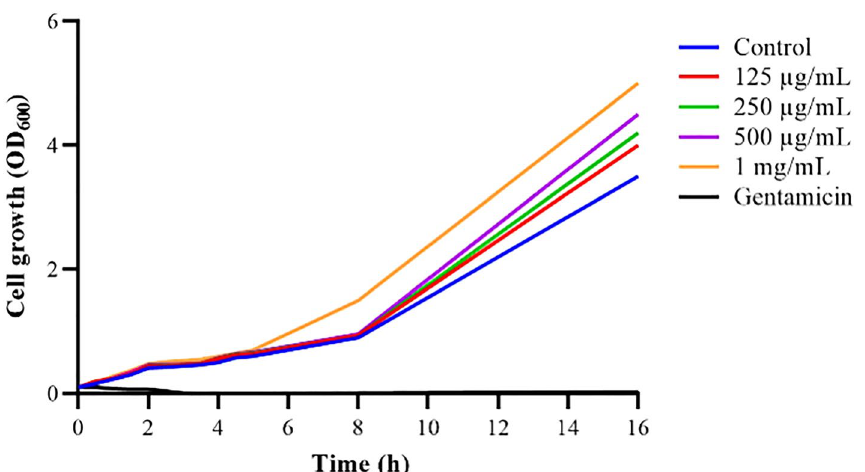
Figure 3. The effect of Alhagi maurorum extract at different concentrations (1000–125 µg/ml) on the growth of P. mirabilis in TSB media (solid line) or supplemented with the optimal value of Alhagi maurorum aqueous extract (dashed line). The data represent the absorbance of the mean ± SD values of experiments performed in